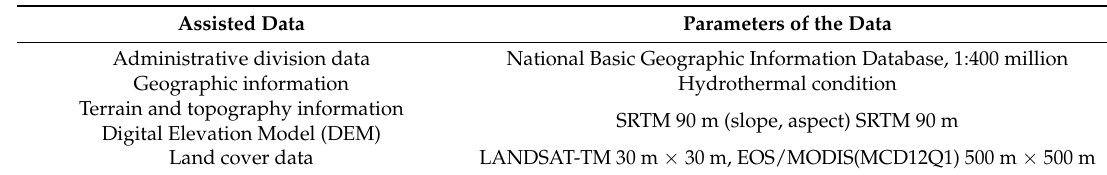
Table 1. The model-assisted parameter